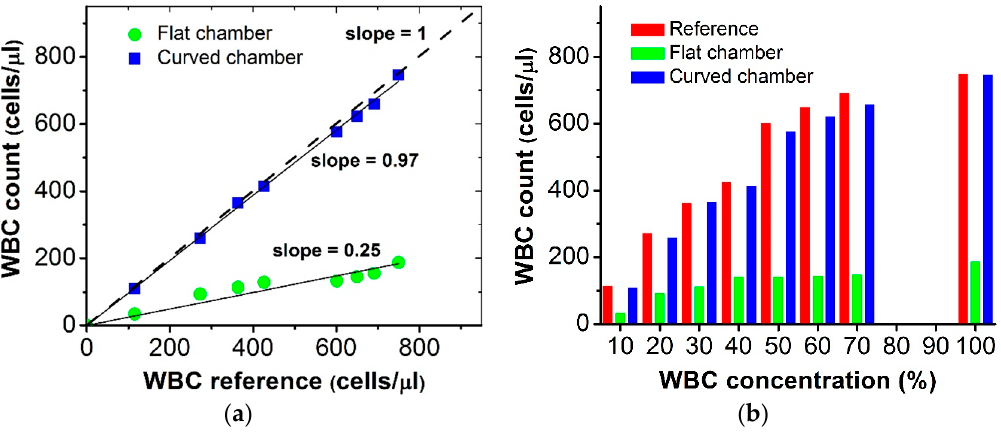
Figure 9. ( a ) WBC count obtained using planar chamber is remarkably different from the reference cell count obtained with conventional microscopy; and ( b ) WBC concentrations of 10%–70% with an interval of 10% and 100% were compared for absolute counting obtained by microscopic, flat, and curved chamber imaging. The count obtained with the curved chamber is close to that obtained with conventional microscopy. However, the corresponding result with the flat chamber differs considerably for large fields.